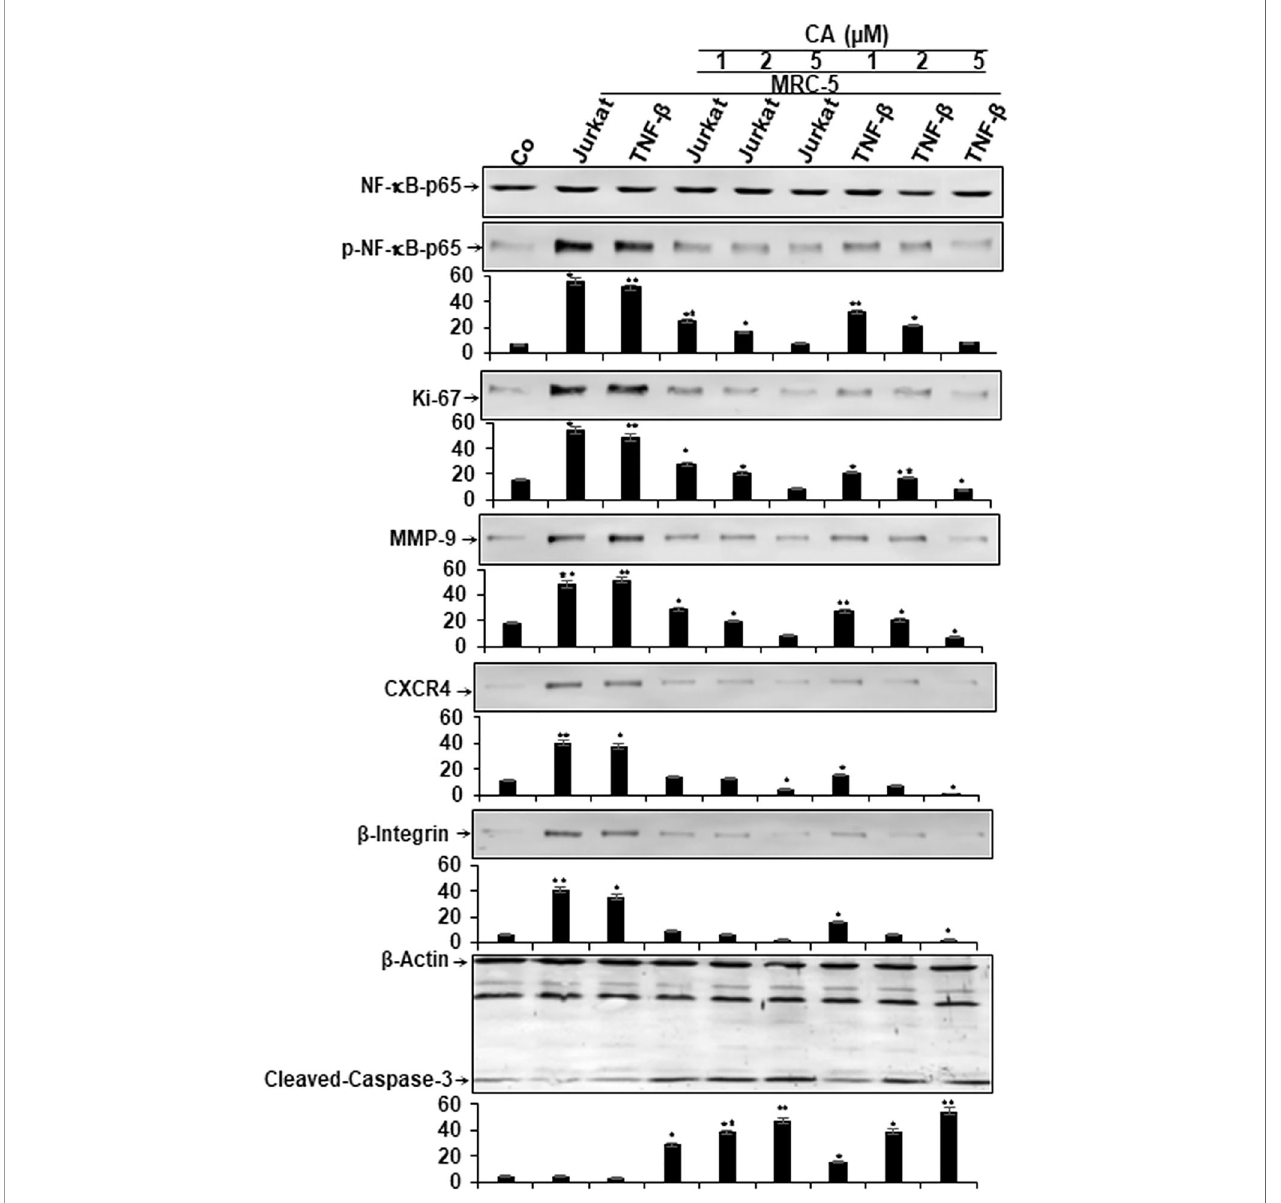
FIGURE 5 | Effect of Calebin A on multicellular proin fl ammatory TME-induced activation of NF- k B and NF- k B-regulated gene end-products in CRC cells. Serum starved cultures of HCT116 cells in 3D-alginate cultures alone (co) or co-cultured with fi broblasts and T-lymphocytes or co-cultured with fi broblasts and TNF- b (10 ng/ml) were either left untreated or treated with various doses of Calebin A (CA) (1, 2, and 5 µM), as described in Materials and Methods . Immunoblotting of whole- cell lysates from HCT116 was performed for anti-p65-NF-kB, anti-phospho-p65-NF- k B, anti- b 1-integrin, anti-MMP-9, anti-CXCR4, anti-Ki67, and anti-cleaved- caspase-3. b -Actin served as an internal loading control in all experiments. For densitometric evaluation, results are compared to control, and * p < 0.05 and ** p < 0.01 were considered statistically signi fi